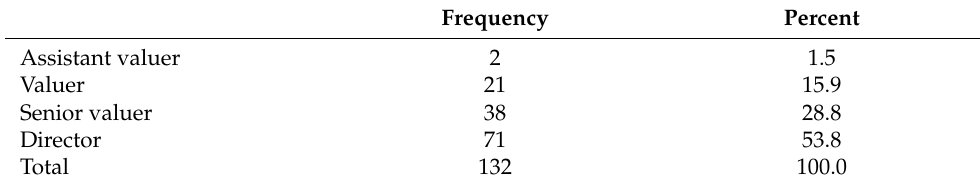
Table 3. Designation of the